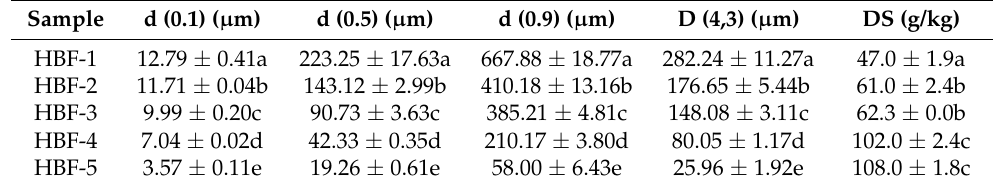
Table 1. The different particle size distributions and damaged starch content of highland barley flour.